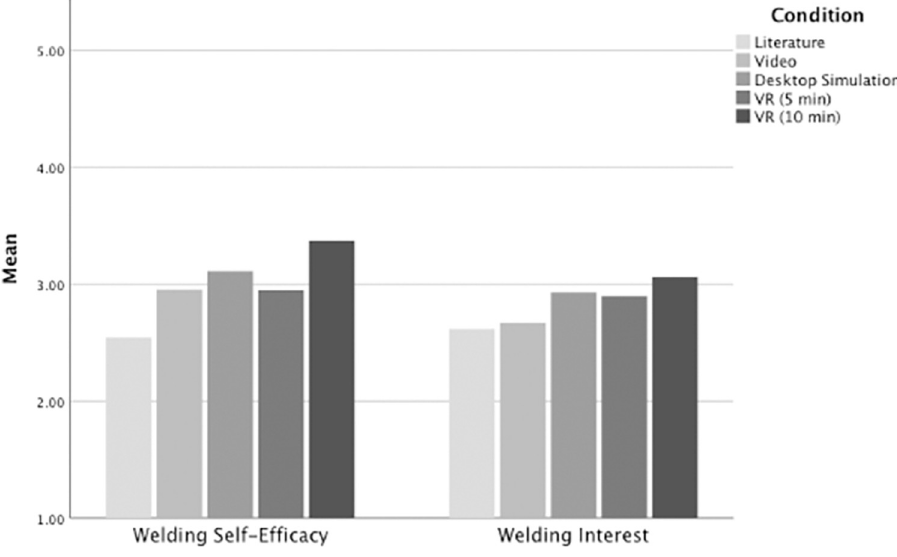
Fig 1. Welding self-efficacy was higher for participants in the long-exposure VR condition. Welding self-efficacy (left) and interest (right) by condition. The conditions are (from left to right) literature, video, desktop simulation, VR (5-min), VR